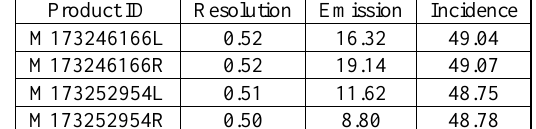
Table 1. Algorithm for tracing an epipolar curve. TraceEpipolarCurve